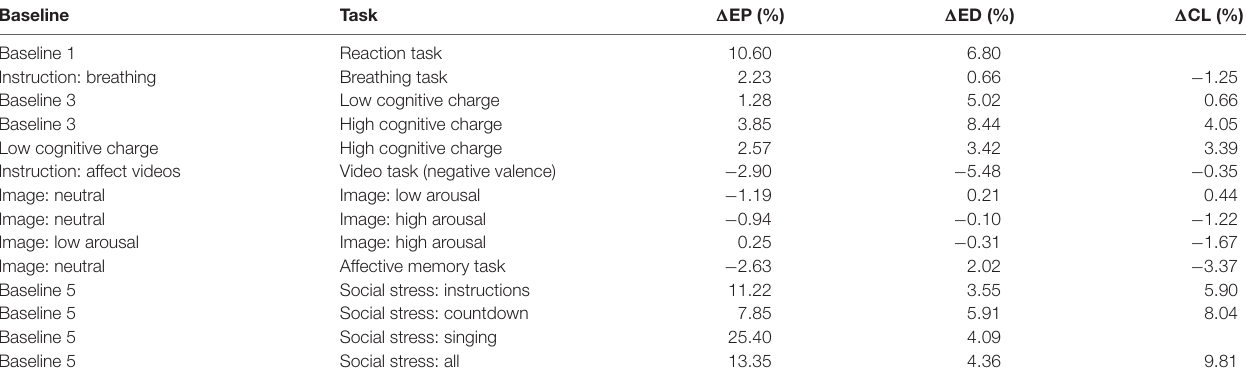
TABLE 5 | Difference by task: the phases used as the baseline are listed in the first column and the tasks are listed in the second column. Baseline Task ∆ EP (%) ∆ ED (%) Baseline 1 Baseline 3